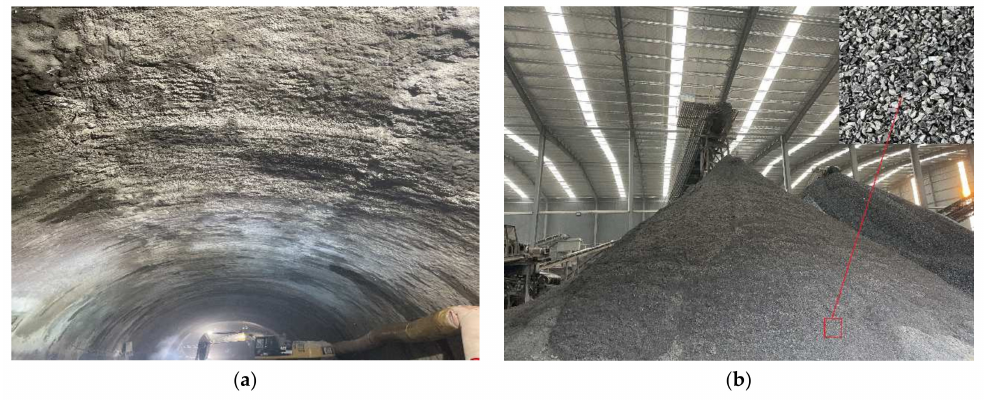
Figure 1. Manufactured sand. ( a ) Excavated tunnel; ( b ) Manufactured